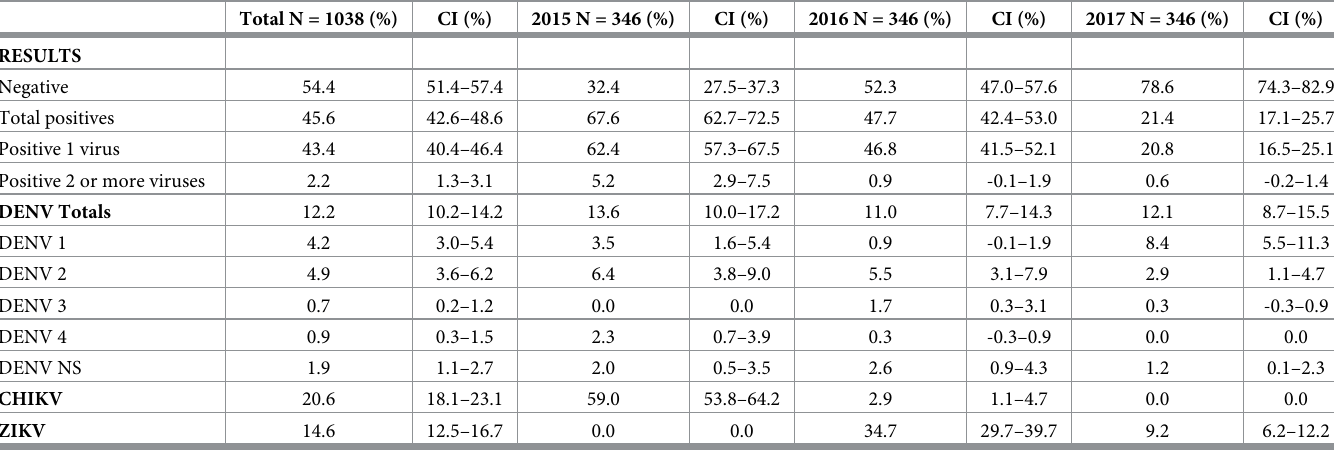
Table 3. Positivity found for each